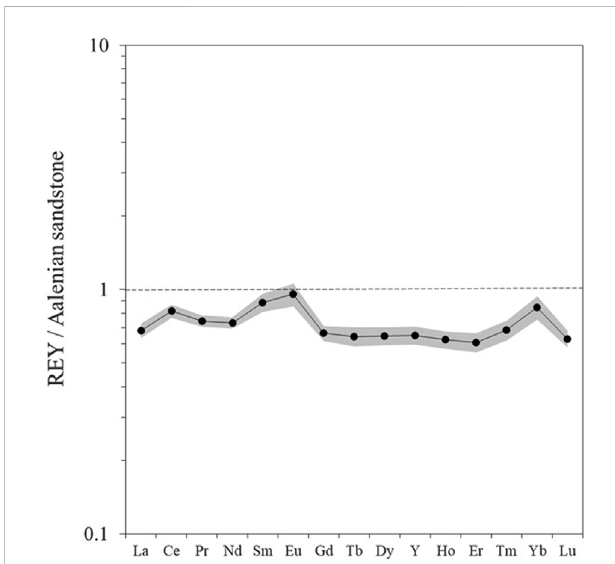
FIGURE 7 Aalenian calcareous sandstone-normalized REY patterns for the 16 riverbank samples of group IV at JOEP and BETHUP. The black line corresponds to the average value and the light grey area to the standard deviation ( n =16).